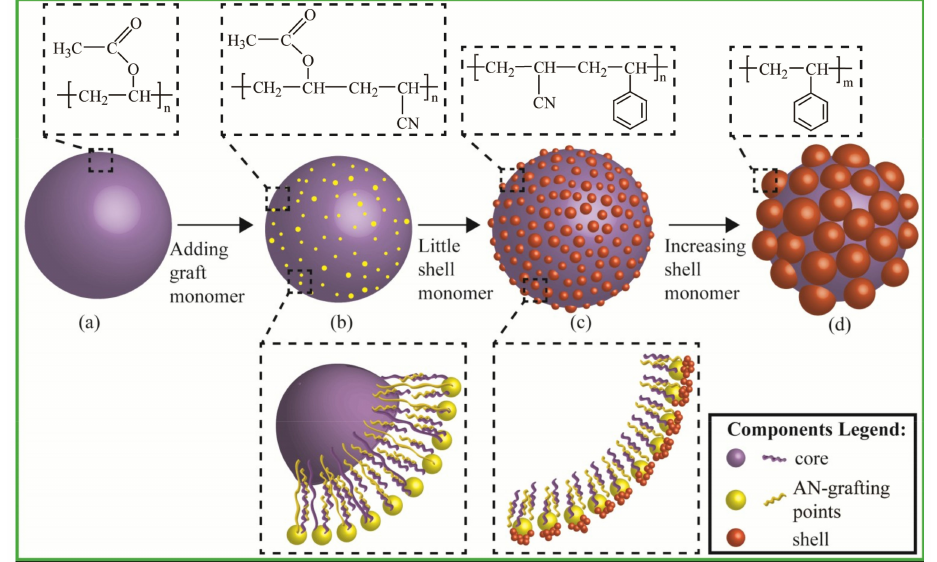
Figure 8. Schematic illustration for fabrication of PVAc-AN/PS inverted core-shell structured latex particles mediated by surface grafting points on PVAc-based core. ( a ) PVAc core; ( b ) core with active points; ( c ) core/shell with “peeled pomegranate”; ( d ) core/shell with strawberry